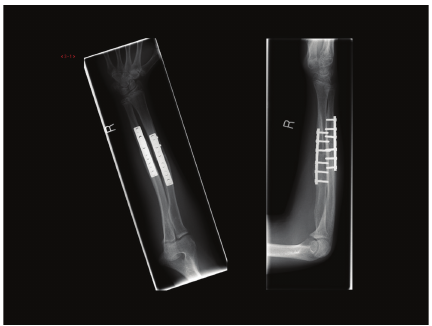
Figure 4: Postoperative results—orthogonal views at twelve